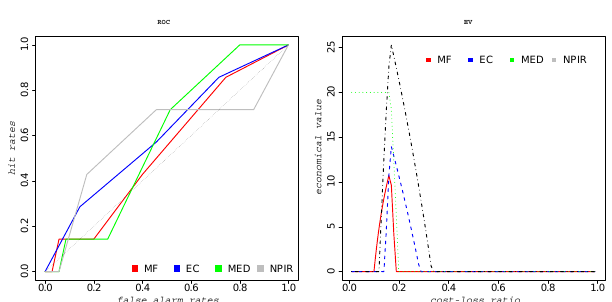
Fig. 7. HPE ROC curves (left; false alarm rates in abscissa, hit rates in ordinate) and Economical Value curves (right; cost-loss ratio in abscissa, economical values in ordinate) for the direct methodology, from each forecast